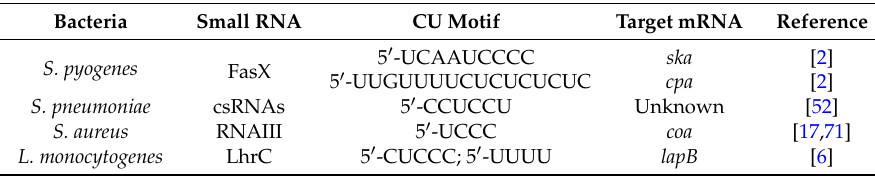
Table 2. CU motifs in sRNA:mRNA interactions in gram-positive bacteria.